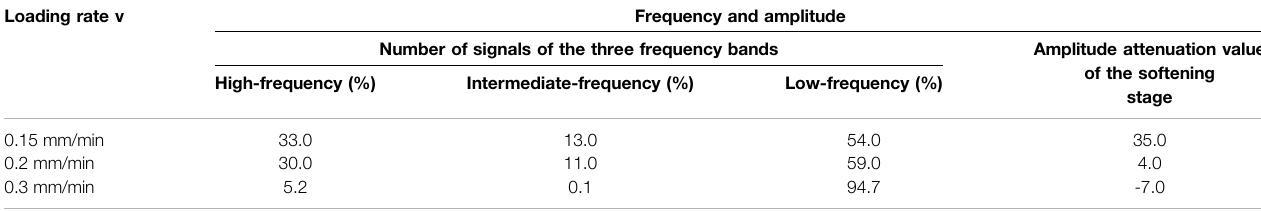
TABLE 5 | Number of signals of the three frequency bands and amplitude attenuation value of the softening stage under different loading rates. Loading rate v